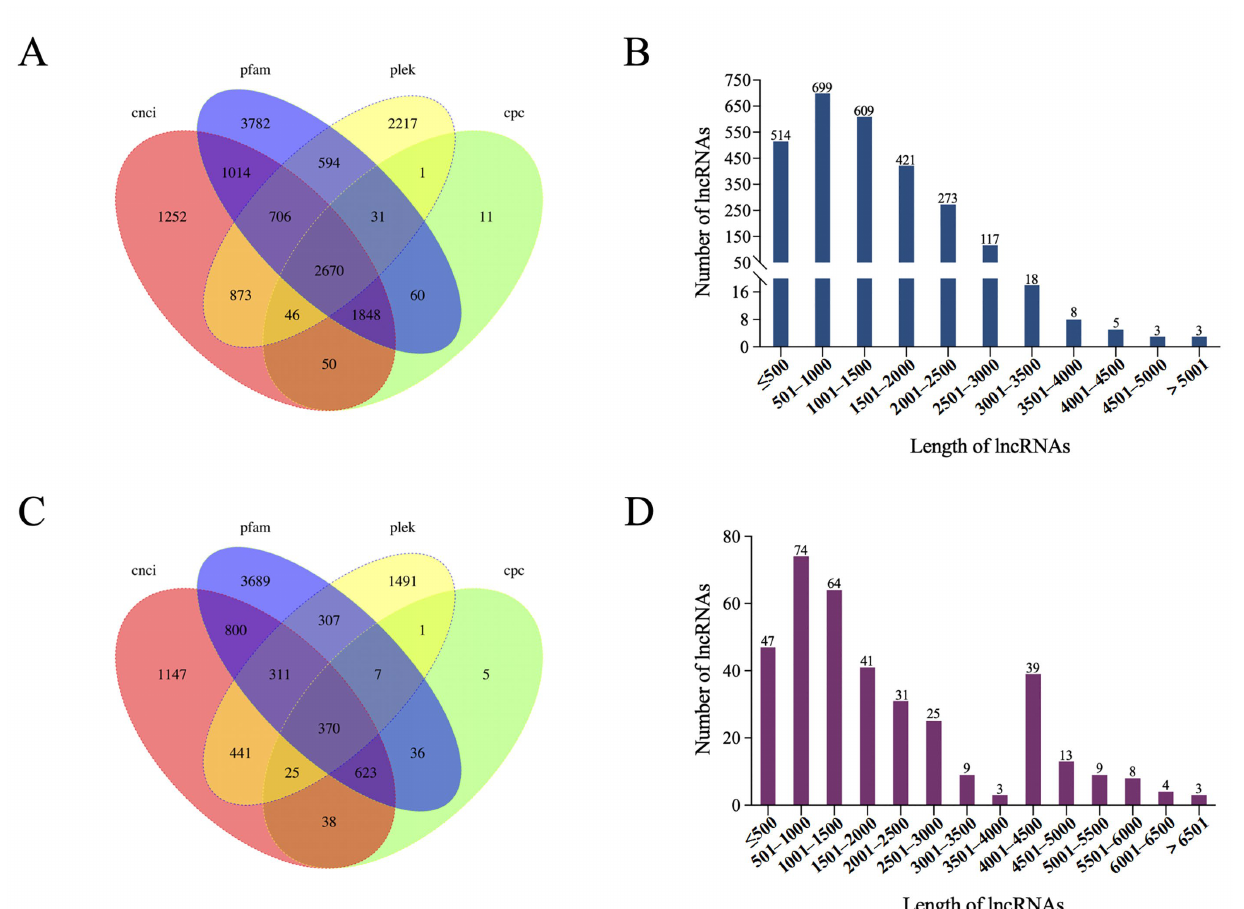
Figure 11. Identification of lncRNAs in CSBV Bces-Po19-sensitive (S) and -resistant (R) Japanese flounder ( Paralichthys olivaceus ). ( A ) Venn diagram of the number of lncRNAs predicted by CNCI, PLEK, CPC, and Pfam in the CSBV Bces-Po19-resistant group. ( B ) Distribution of lncRNAs identified in HCSBV Bces-Po19-resistant group. ( C ) Venn diagram of the number of lncRNAs predicted by CNCI, PLEK, CPC, and Pfam in the CSBV Bces-Po19-sensitive group. ( D ) Distribution of lncRNAs identified in CSBV Bces-Po19-sensitive group.